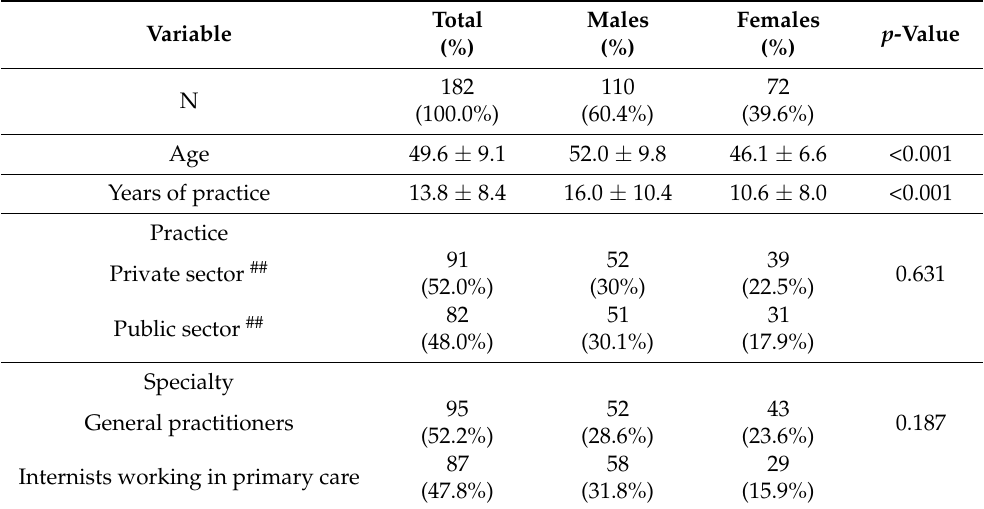
Table 1. Demographic characteristics and work status of survey